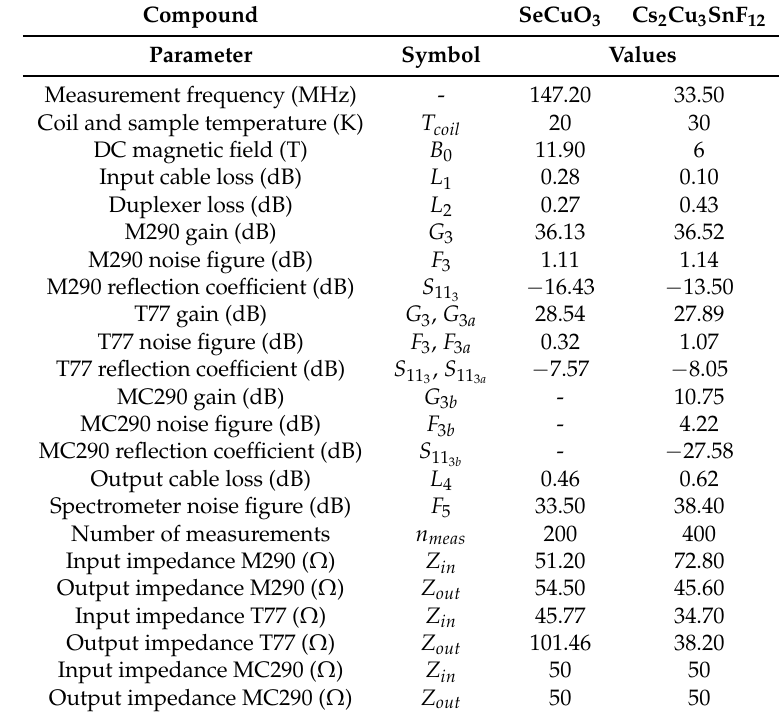
Table 1. Electric parameters of receiving chain elements used in both sets of measurements.